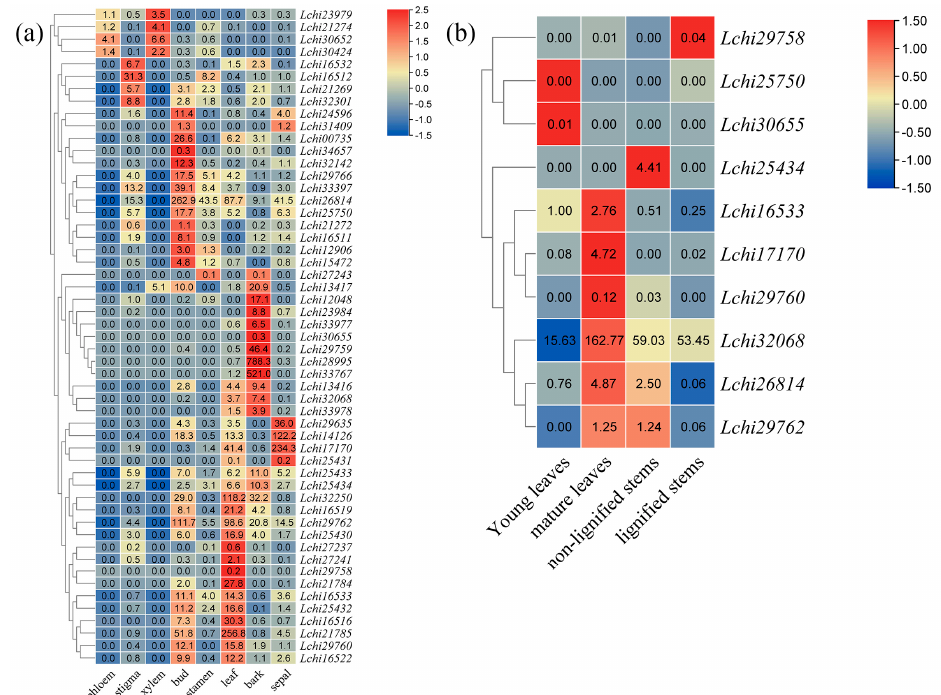
Figure 5. The expression dynamics of LcTPS genes across different tissues. ( a ) The expression levels of LcTPS genes were extracted from transcriptome data and quantified using transcripts per million (TPM). ( b ) Expression levels of selected LcTPS genes in young leaves, mature leaves, non − lignified stems, and ligni fi ed stems by qRT − PCR. The mean expression value was calculated from three in- dependent biological replicates in di ff erent samples. The raw data of relative expression values and standard errors are provided in Table S3.